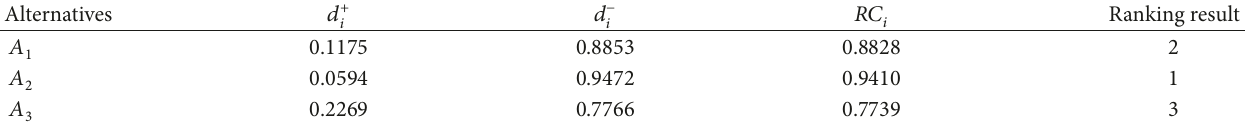
Table 9: The result of TOPSIS